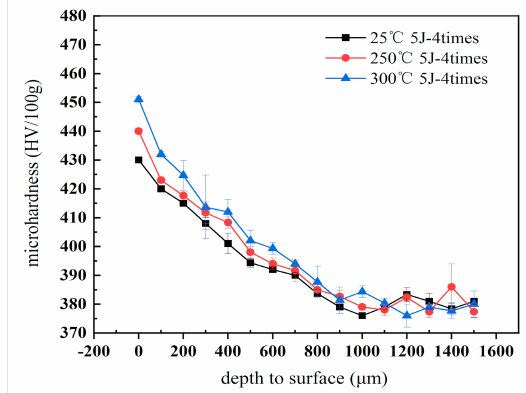
Figure 4. Microhardness distribution along the cross-sectional depth